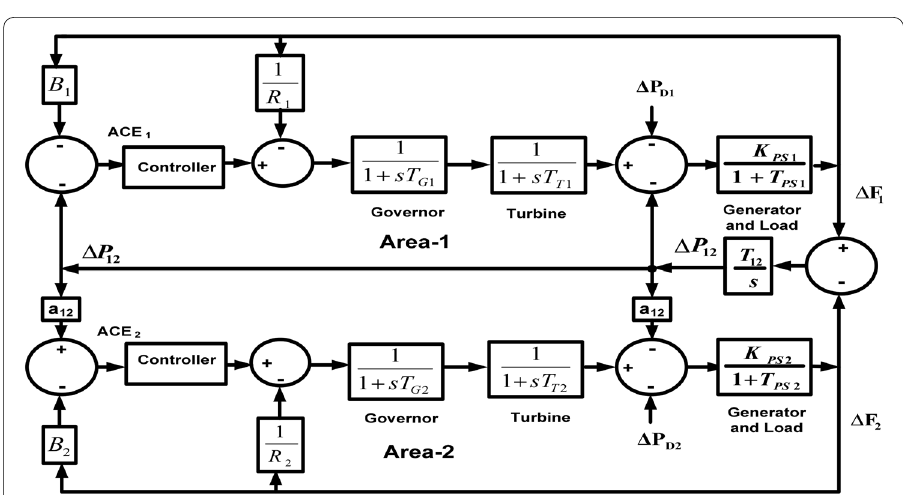
Fig. 2 Non-reheat-type 2-area thermal system (Test system-II)